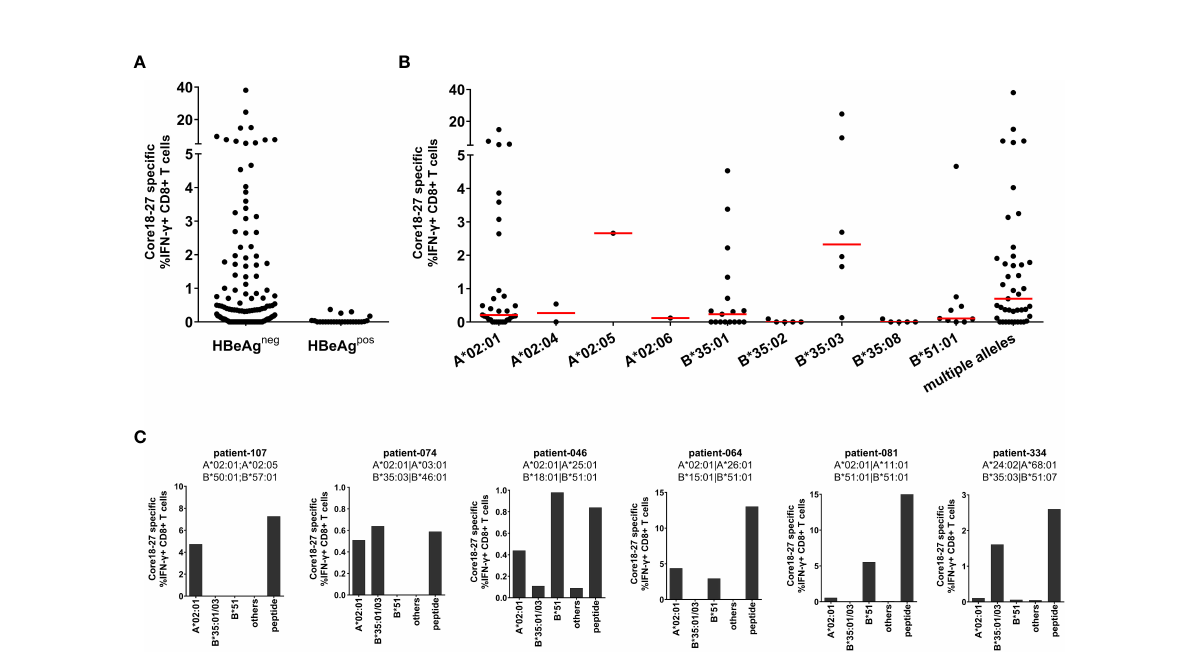
FIGURE 1 The core 18-27 epitope is restricted by multiple HLA class I molecules. PBMCs from 154 patients with chronic HBV infection were stimulated for 10 days in the presence of the core 18-27 peptide and re-stimulated for 5h before IFN g production was determined by ICS. Depicted are IFN g producing HBV core 18-27 speci fi c CD8 T cells, the IFN g response from non-stimulated cell was subtracted (A) IFN g responses according to the HBeAg status. (B) IFN g responses according to the HLA-type of the HBeAg negative patients from (A) . Patients depicted with single HLA-types had no other relevant HLA-type (e.g. A*02:01 are patients negative for HLA-B*35:01/03 or HLA-B*51 and vice versa), patients with “ multiple alleles ” had at least two relevant HLA-alleles (e.g. A*02:01 and B*51). (C) The HLA-restriction of antigen-speci fi c CD8 + T cells was determined with partially HLA- matched peptide-pulsed target cells expressing only HLA-A*02:01 (not B*35 or B*51), B35:01/03 (not A*02:01 or B*51), HLA-B*51 (not A*02:01 or B35), others (not A*02:01, B*35 or B*51). As control core18-27 peptide was directly added to the culture (peptide). The frequency of IFN g